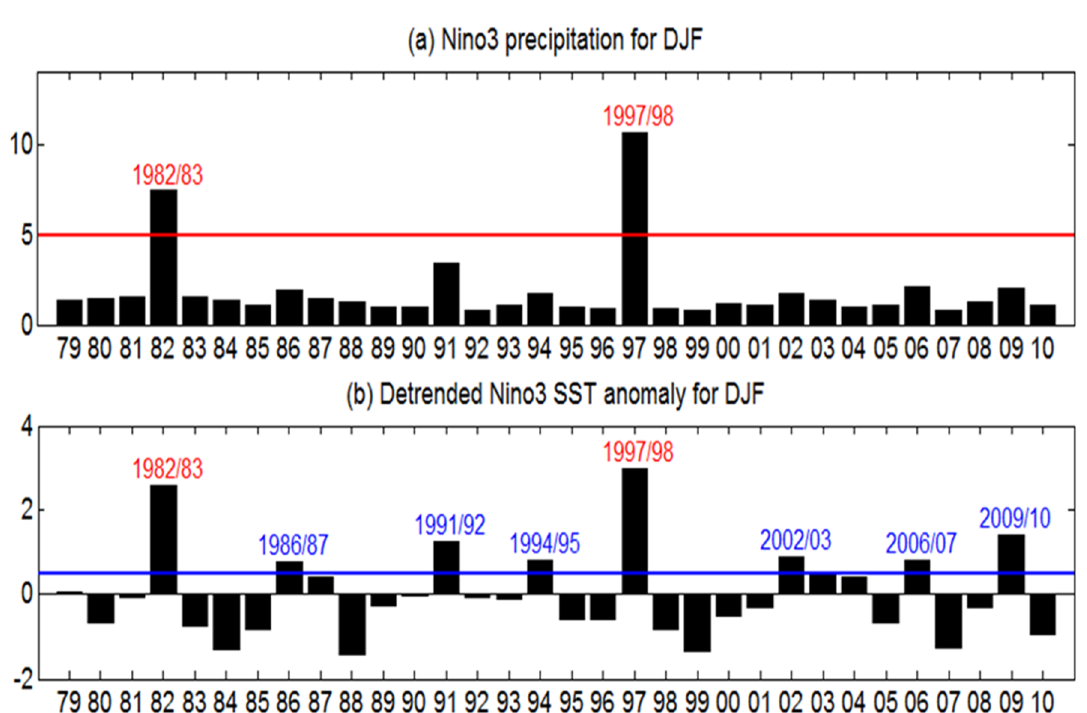
Figure 1. Time series of December–January–February (DJF) mean ( a ) precipitation (mm/day) and ( b ) detrended SST anomalies (°C) over the Niño3 (150° W–90° W, 5° S–5° N) region during 1979–2010 in observations. The red line in ( a ) and the blue line in ( b ) denote the 5 mm/day precipitation and 0.5 °C SST anomaly, respectively. The events of 1982/83 and 1997/98 are two extreme episodes, with more than 5 mm/day mean precipitation over the Niño3 region during DJF, as shown in ( a ). Based on the definition that detrended Niño3 SSTs greater than 0.5 °C are anomalies but not extreme El Niño events, we also identified six moderate El Niño events, as shown in ( b ).